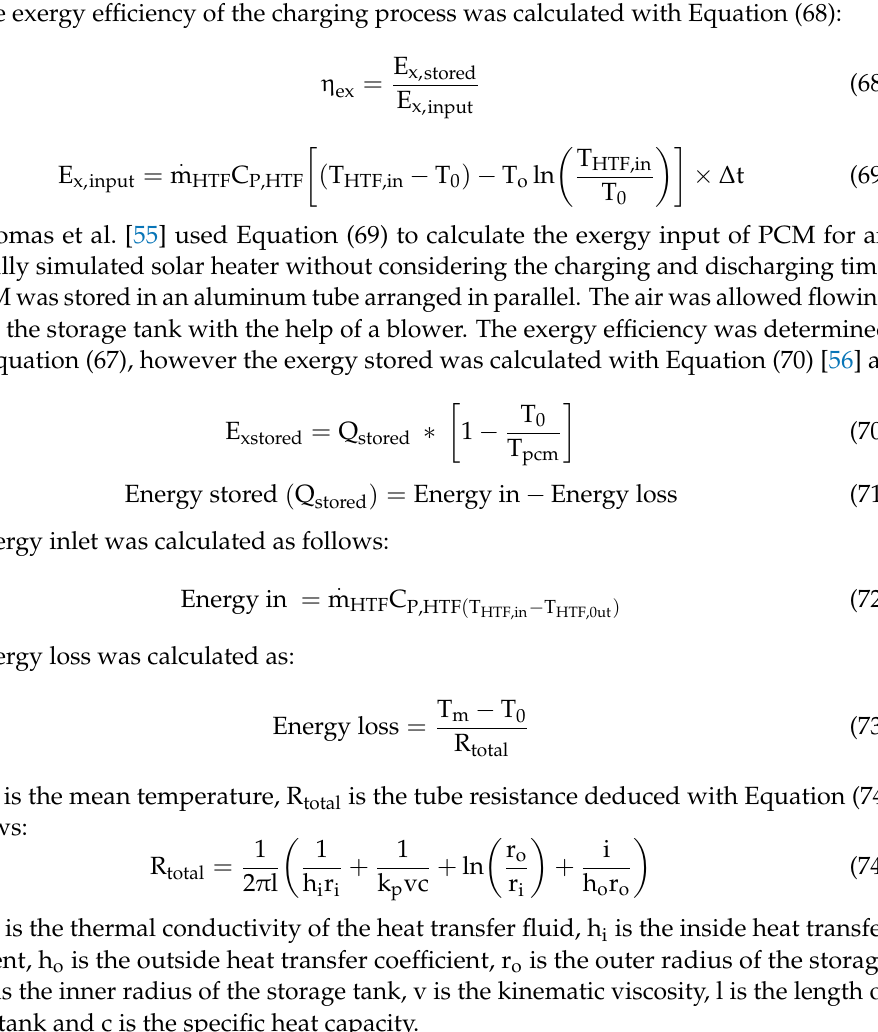
Figure 7. Schematic computational domain for the charging and discharging process (source: Solomon and Oztekin [68]).